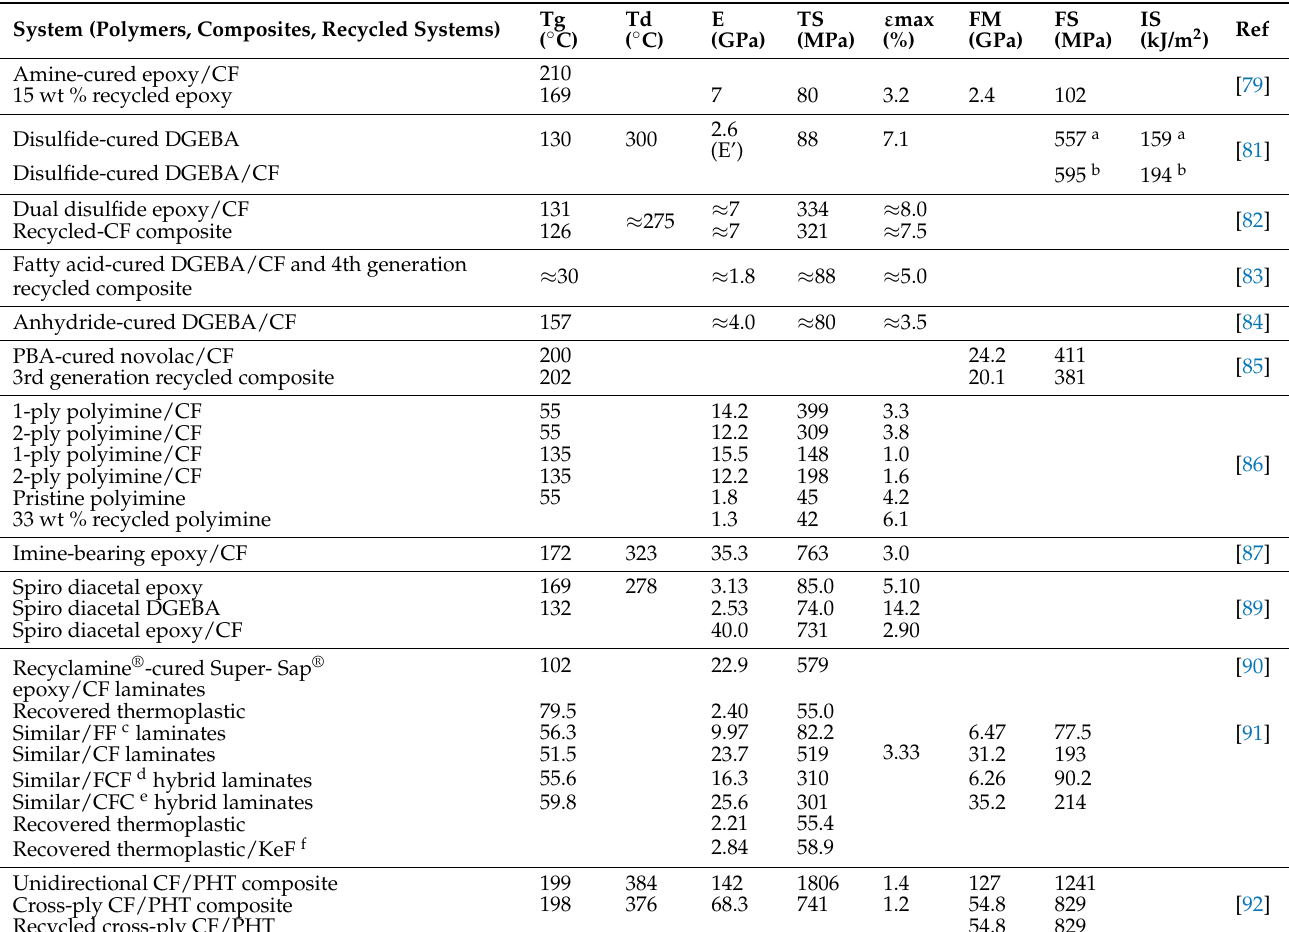
Table 5. Summary of mechanical and thermal properties of the reviewed TSFRP composites and recycled composites. System (Polymers, Composites, Recycled